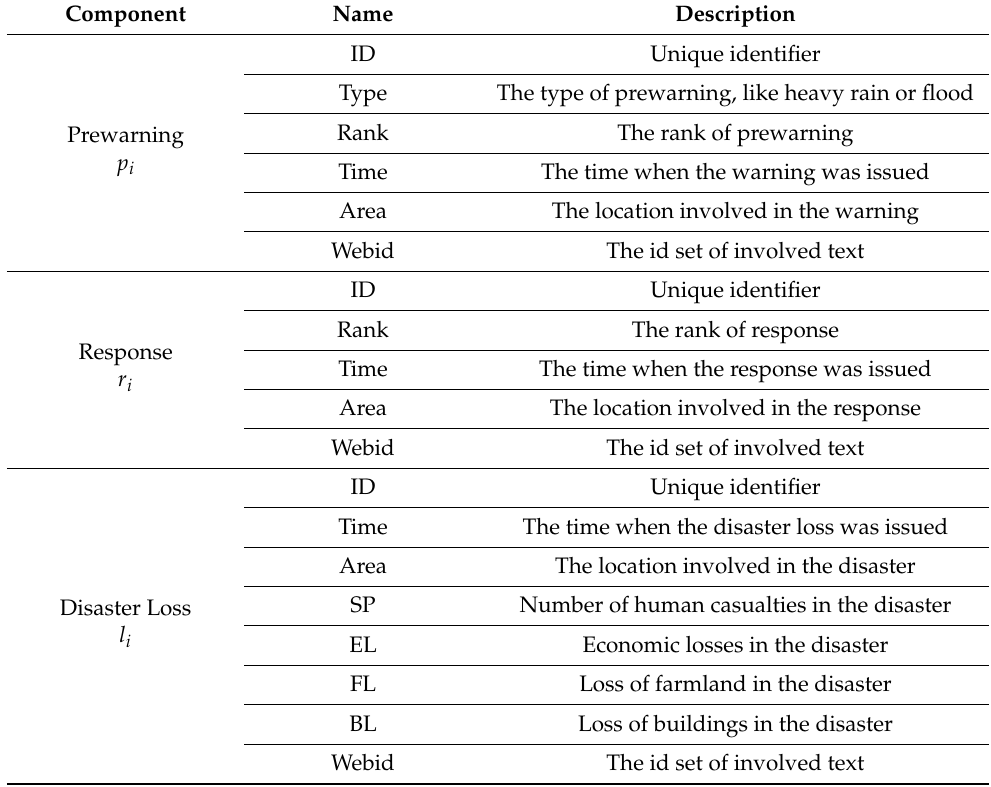
Table 1. The structure of each component in the disaster element.